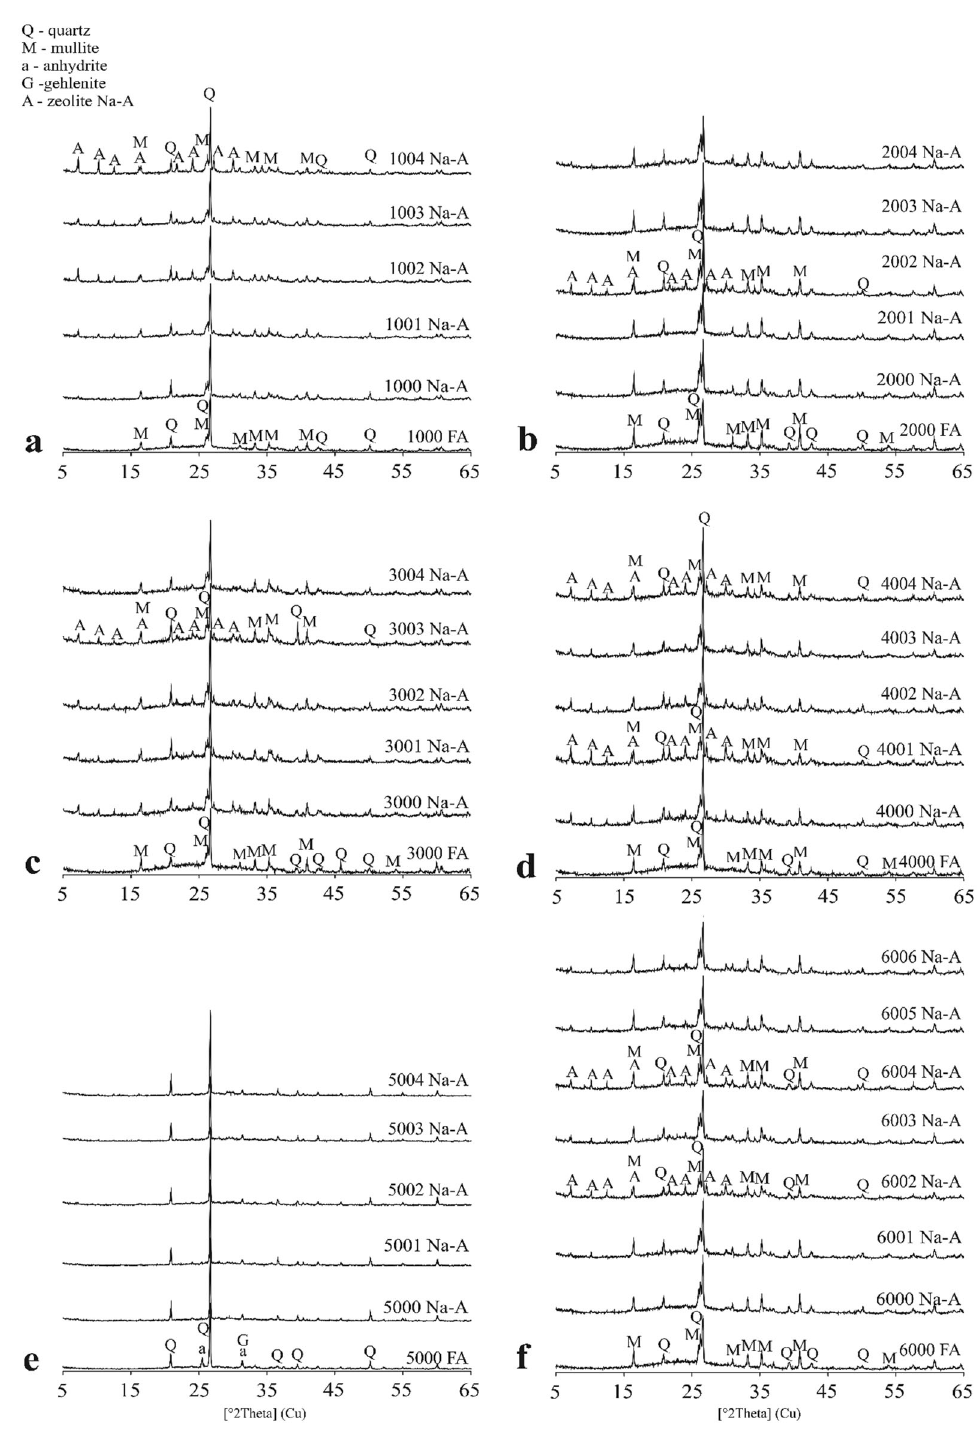
Fig. 3 XRD analyses of raw fly ashes and attempts of Na-A